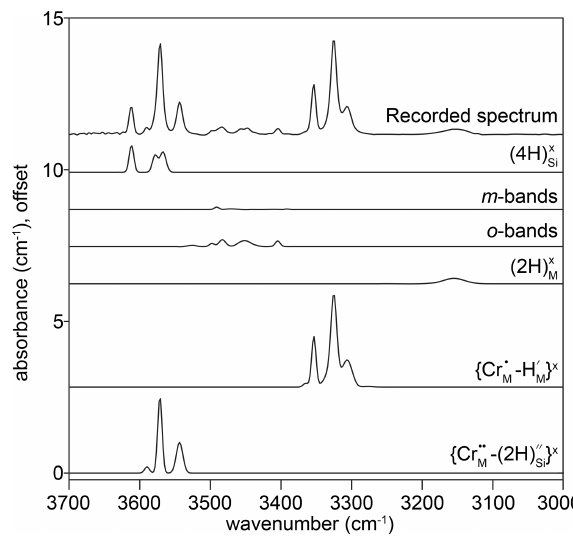
Figure 4. The FTIR spectrum recorded at the interface of sam- ple HYCRa06 (950 ◦ C, 1.5GPa, Ni–NiO, fo-en), resolved into 24 peaks, which were then grouped into six associations. The peak identities, or proposed identities, are given. The recorded spectrum is also shown in Fig. 3d.